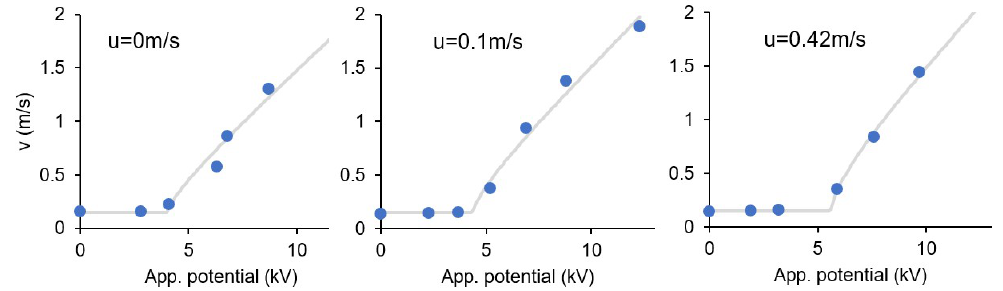
Figure 12. Experimental (blue dots) and fitted values (grey lines).